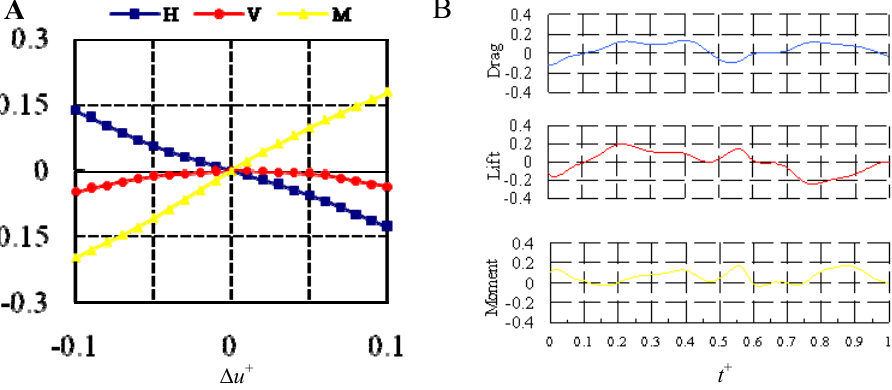
Fig.5 (A) x -component and z -component of forces and pitching moment when the x -component of velocity u varies in a range of -0.1~0.1. (B) Time course of the differences in lift, drag and pitching moment with respect to the reference flight condition at Δ u + =0.06 . t + is a dimensionless time